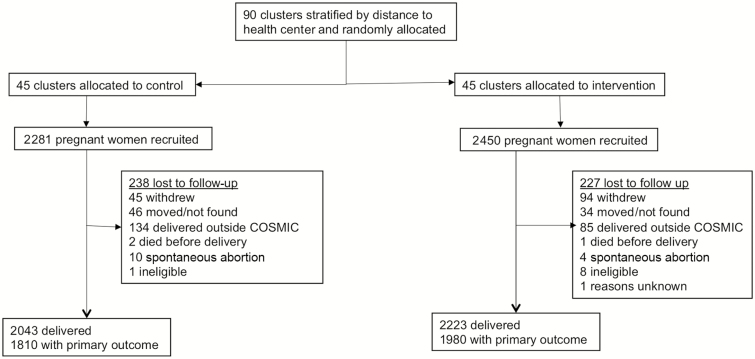
Flowchart of the cohort of pregnant women enrolled in the study. Primary outcome is placental malaria for the Burkina Faso and The Gambia study sites and maternal peripheral infection at time of delivery for the Benin study site.